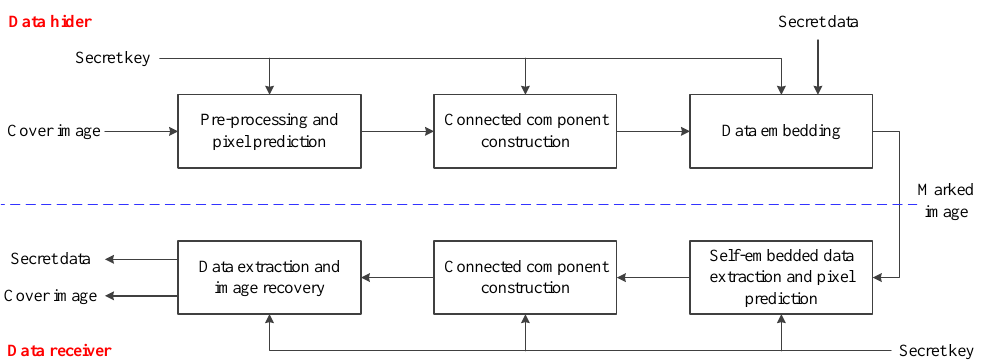
Figure 1. General framework for the proposed